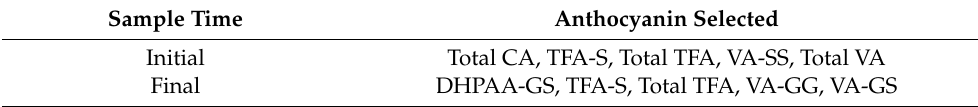
Table 4. Anthocyanin selected by Boruta algorithm.